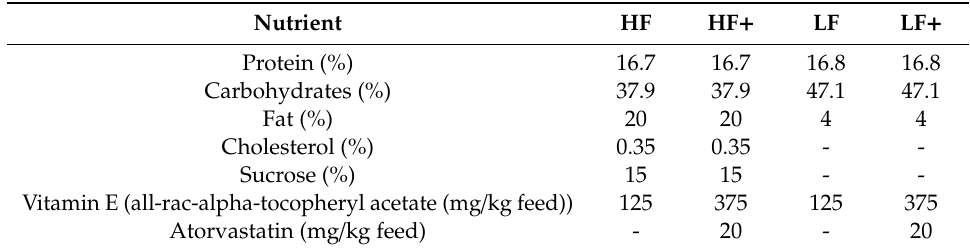
Table 1. Dietary